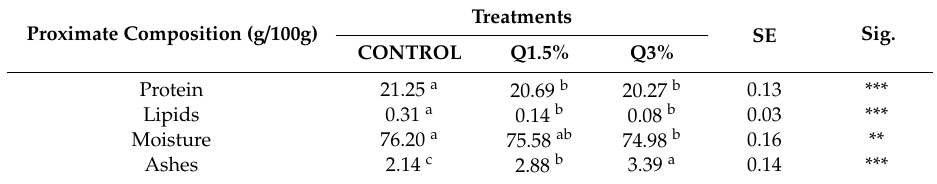
Table 1. E ff ect of the chitosan inclusion on chemical composition of low-fat cooked sausages made from turkey meat a ff ected by white striping myopathy.